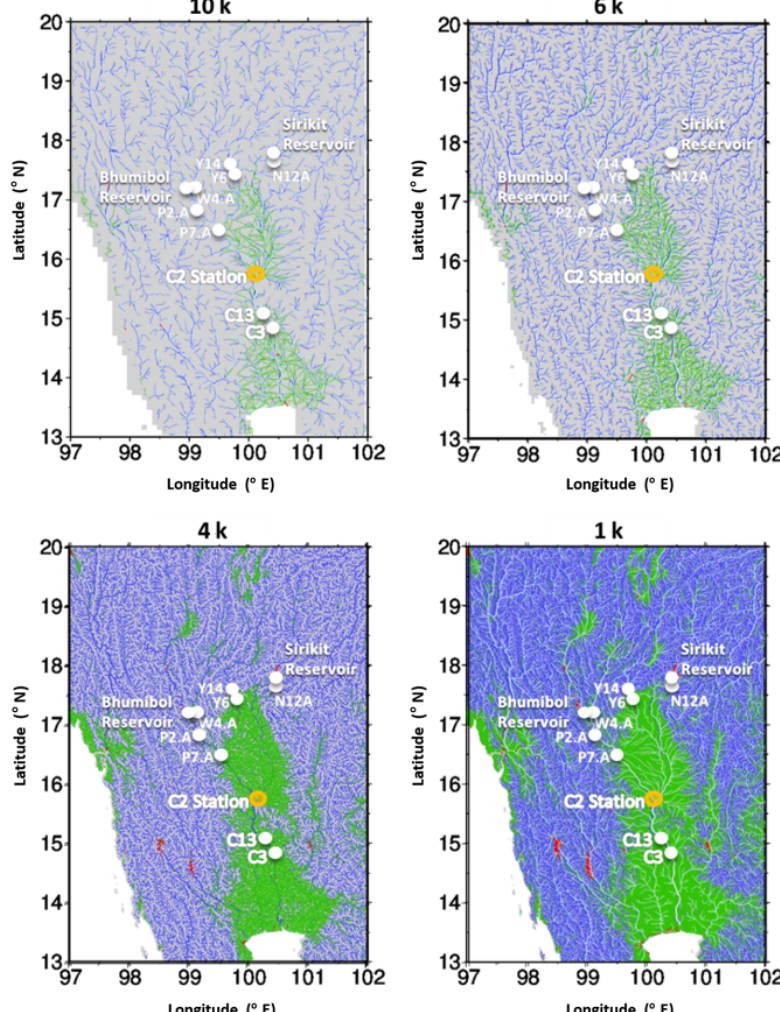
Figure 4. Change in the density of MDC pathways with spatial resolution. The density of river network and MDC pathways increase with increasing spatial resolution. Gauge stations upstream of C2 Station (Y14, Y6, N12A, W4A, P2A, and P7A) are located in zones with low density of MDC pathways. Gauge stations C2, C13, and C3 are located in low-lying and floodplain areas which have a high density of MDC